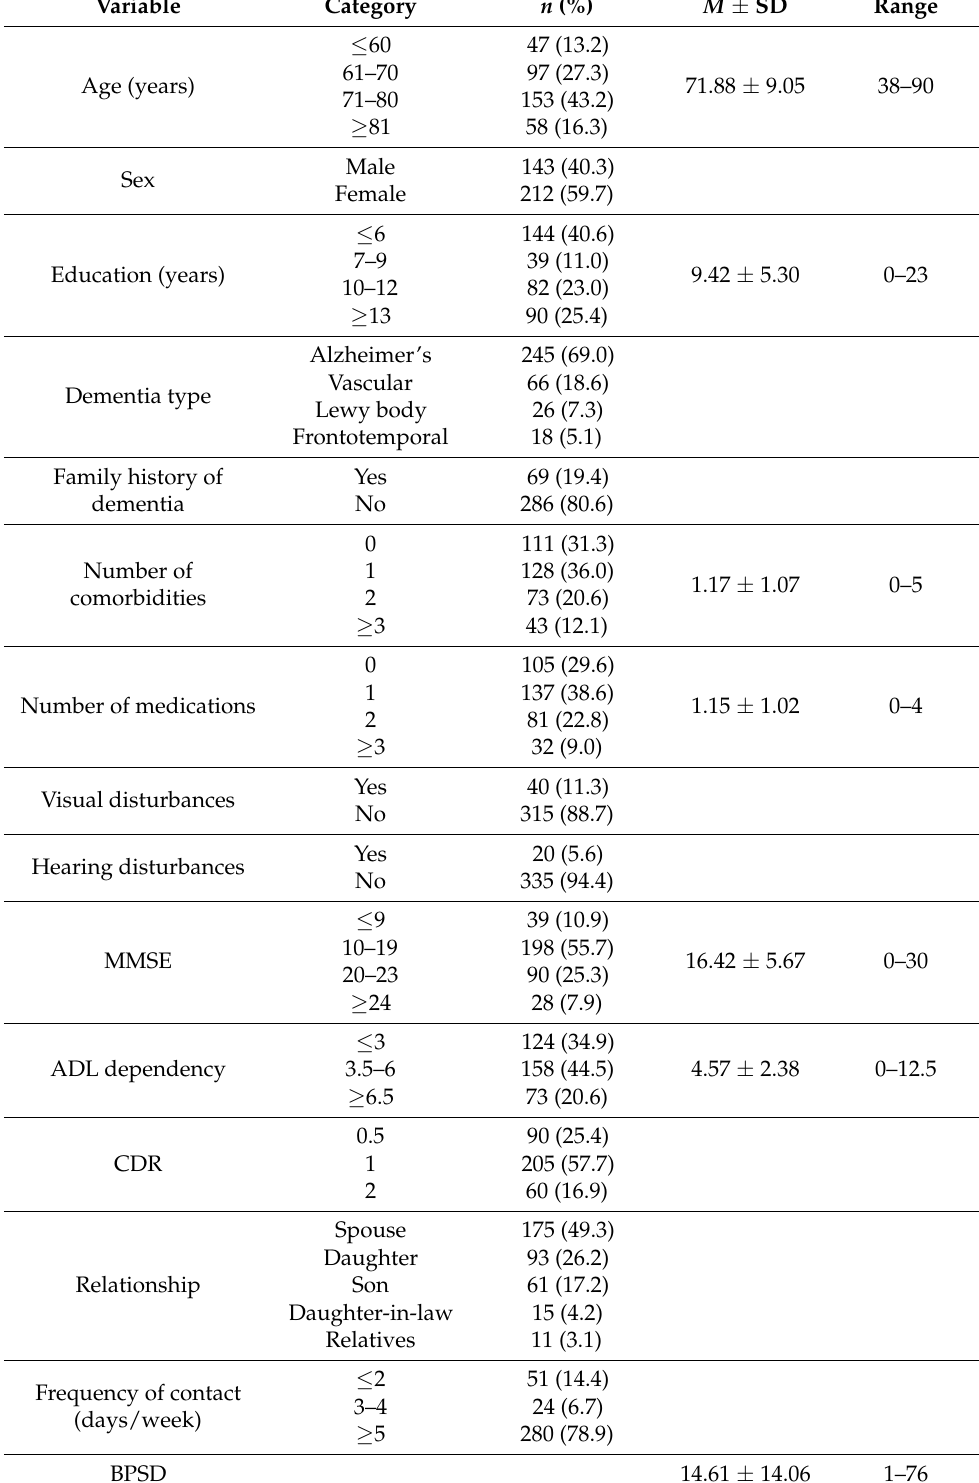
Table 1. Participants’ Characteristics at the First Time of Dementia Diagnosis ( N =